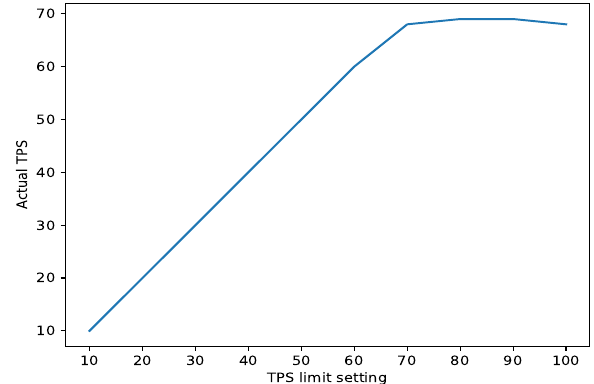
Figure 5. TPS limit of the performance evaluation system.